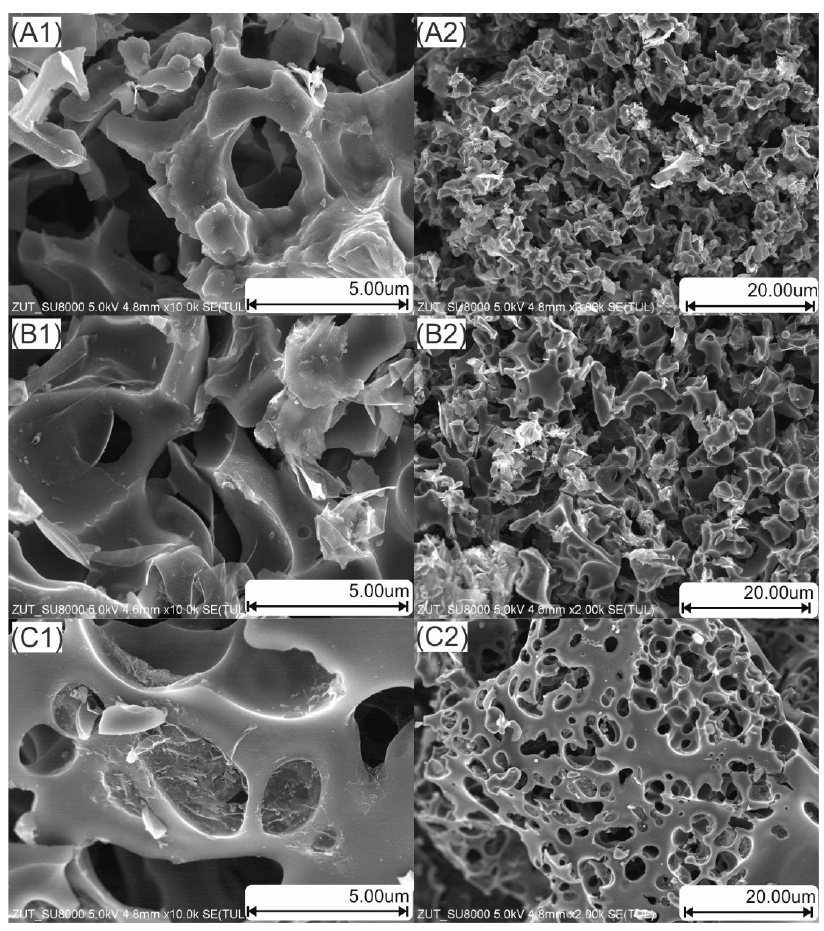
Figure 4. SEM micrographs of the activated carbons ( A1 , A2 )—activated carbon from orange peels, ( B1 , B2 )—activated carbon from coffee grounds, ( C1 , C2 )—activated carbon from sunflower husks).